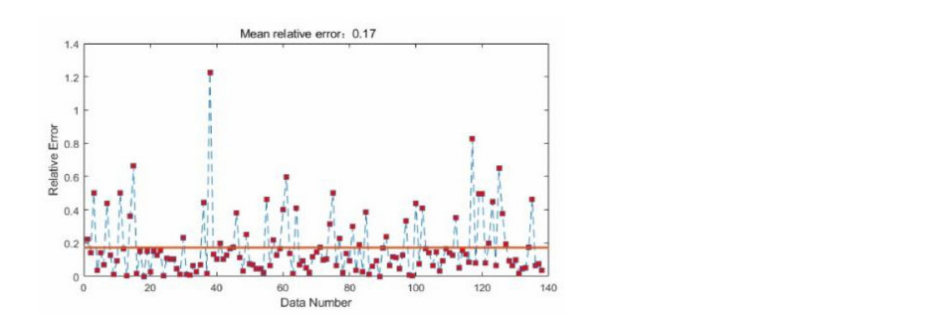
Figure 15. Relative error of generalized regression neural networks. The red line represents the mean relative